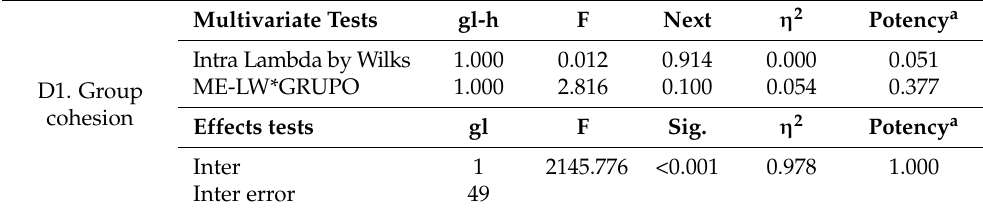
Table 4. Summary of intra–inter subjects univariate MANOVA.